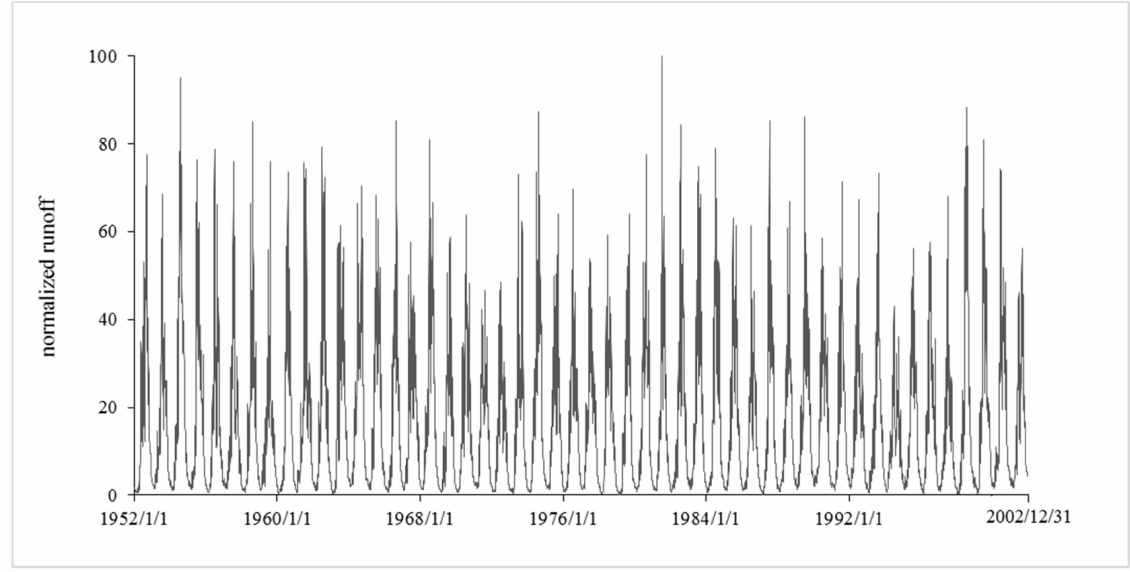
Figure 2. Normalized runoff process (from 0 to 100) analyzed in this research. Original data describe runoff measured at hydrologic station (location: 30 ˝ 42 1 N, 111 ˝ 17 1 E, catchment area: 1.01 ˆ 10 6 km 2 ) in central China. Resolution is 1 day and duration is 50